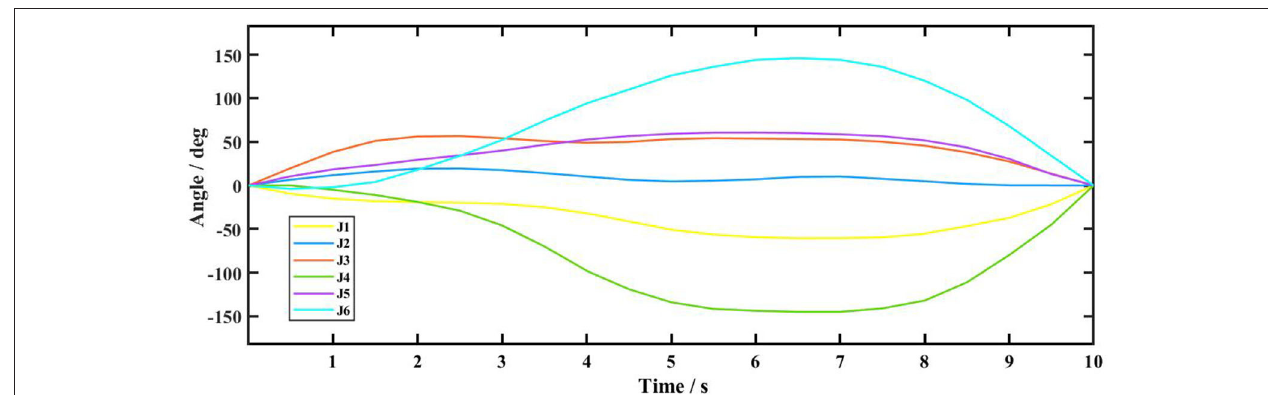
FIGURE 14 | Six-axis displacement curve of